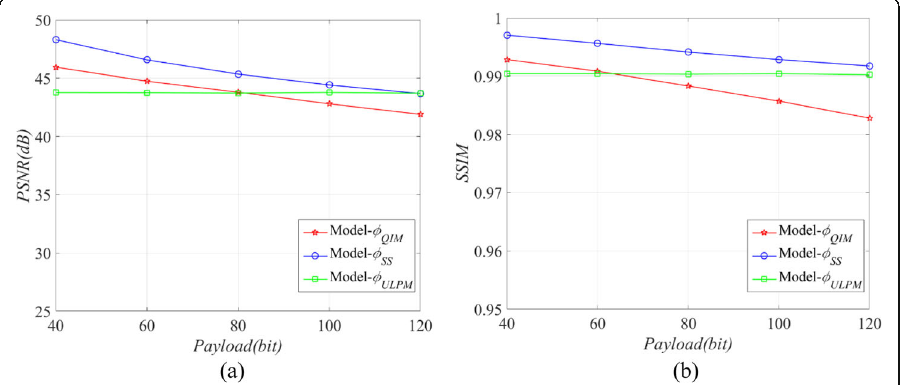
Fig. 4 Image quality of watermarked images with payload 40, 60, 80, 100, and 120 bits processed by Model- ϕ ϕ ϕ QIM , Model- SS , and Model- ULPM for a PSNR and b